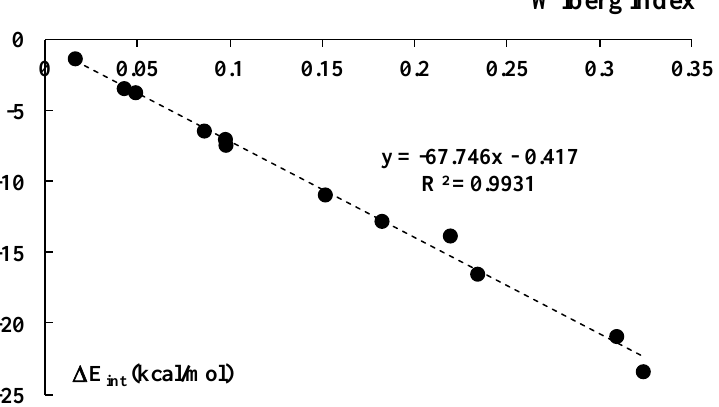
Figure 11. The linear correlation between the Wiberg index and the interaction energy, ∆ E int (Equation (1) and Table 10); the hydrogen-bonded systems are excluded from this correlation.